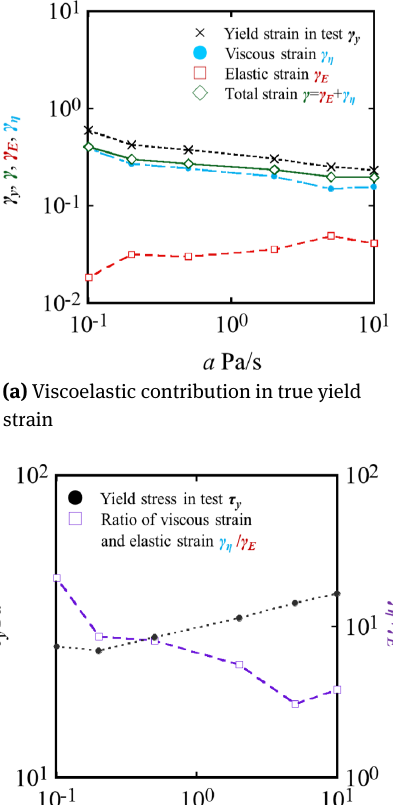
for the α -gel O/W emulsion. Consequently, the yield stress is not constant, whereas the yield strain varies with the stress-ramp rate because the viscous flow influences the strain significantly. Figure 15 shows the contribution of the viscous and elastic strains to the true yield strain. In Fig- ure 15(a), as the stress-ramp rate increases, the elastic strain increases slightly, whereas the viscous strain decreases. The theoretical total strain shows the same qualitative trend as the experimental true yield strain but quantitatively they are different. As mentioned in the Introduction, this regime exhibits complex behavior, including plastic strain and linear-nonlinear transitions. Note that these influences were not evaluated by the single relaxation Maxwell